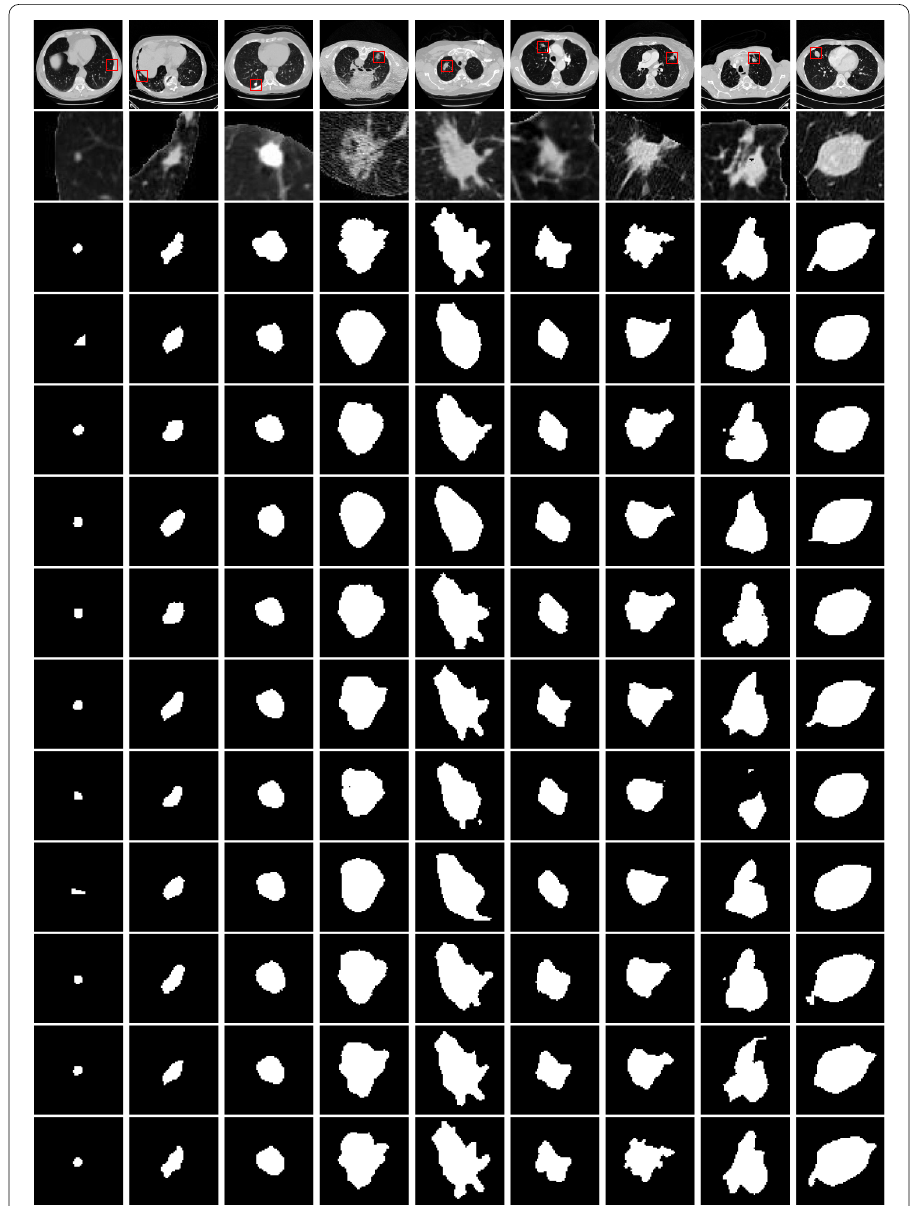
Fig. 14 Original images and segmentation results of pulmonary nodules. From top to bottom: original CT images, ground truth, SegNet [30], ENet [38], PSPNet [39], DeepLabV3 DFANet [41], FANet [43], SPNet [44],